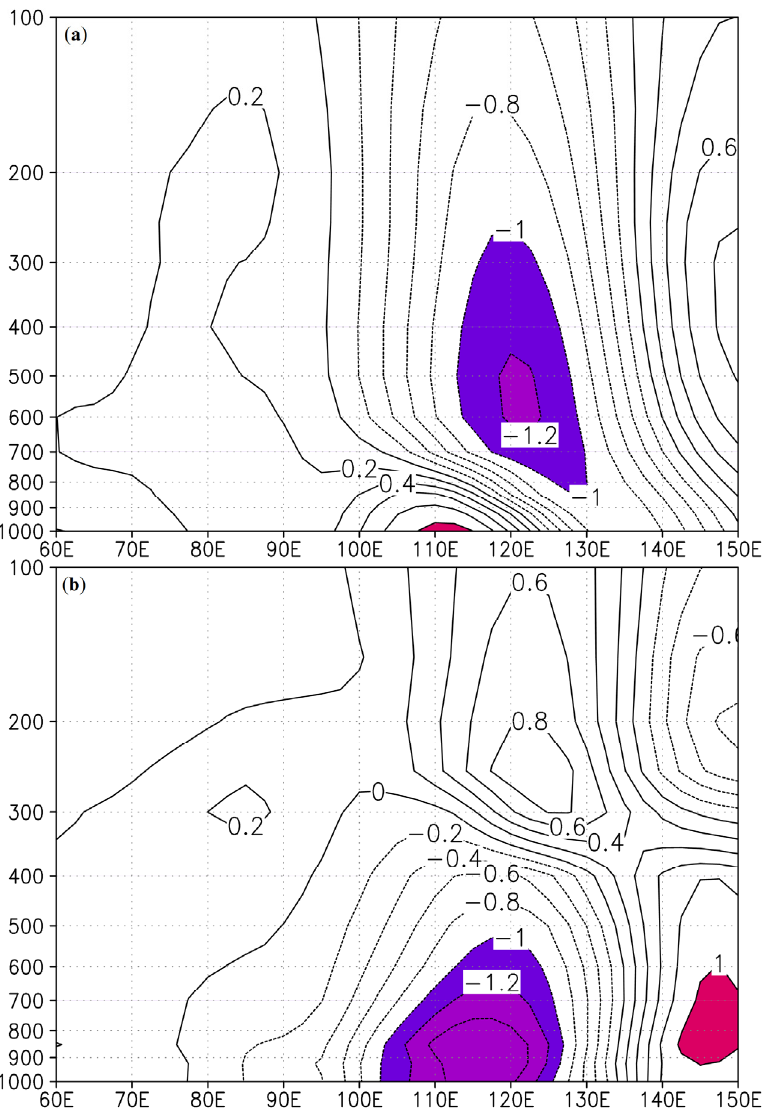
Figure 6. Composites of the longitude–height profiles on all the ECS-occurring days at 40° N for normalized GPH ( a ) and temperature ( b ). Shading means values above one and below − 1.